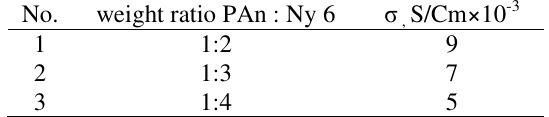
Table 1. Electrical conductivity of PAn/Nylon6 composite prepared in different weight ratio.